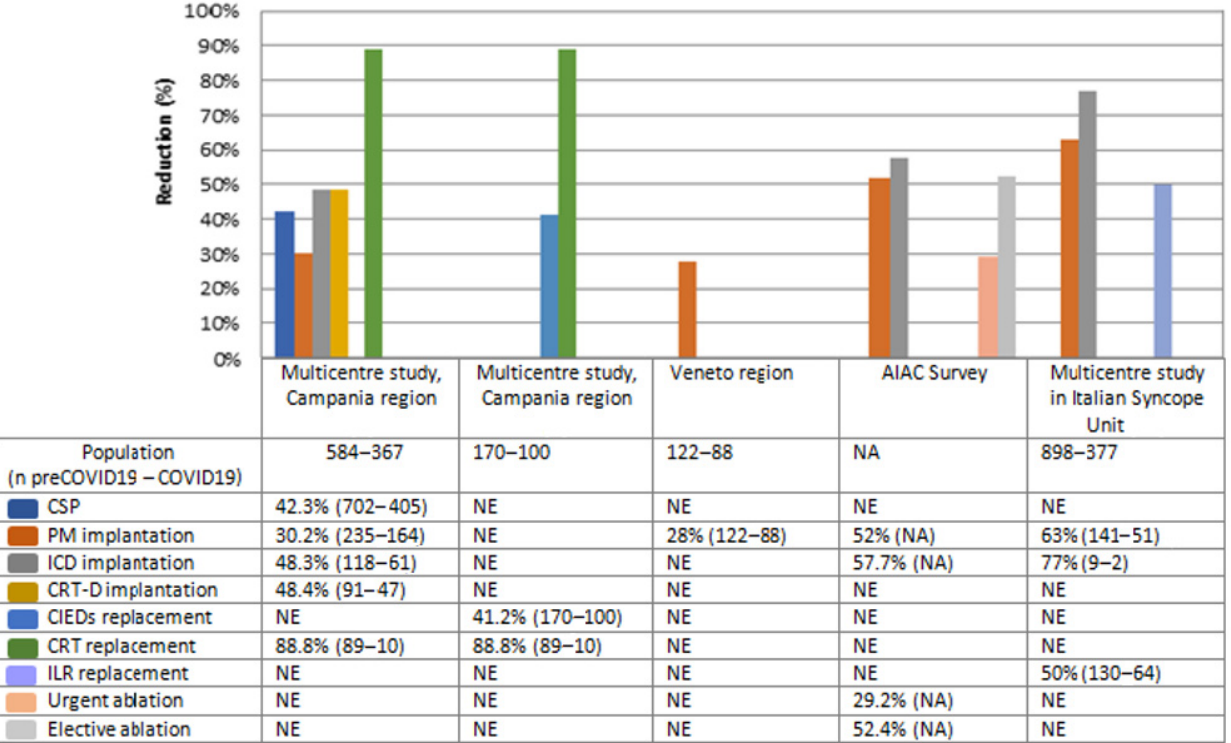
Figure 1. The graph shows the comparison between hospitalization rate relating to CSP in the COVID-19 era and those relating to a previous control period in different Italian hospitals. Reported data refer to Campania region [4,5], Veneto region [6], AIAC survey [7] and a multicentre study from Italian Syncope Units [8]. Each cell shows the percentage reduction in hospitalizations for a specific procedure compared to the pre-pandemic period, followed respectively by the absolute number of procedures in the pre-COVID 19 and COVID 19 era (data in brackets). CSP: Cardiac Stimulation Procedures. PM: Pacemaker. ICD: Implantable Cardioverter Defibrillator. CRT-D: Cardiac Resynchronization Therapy Defibrillator. ILR: Implantable Loop Recorder. NE: Not eval-